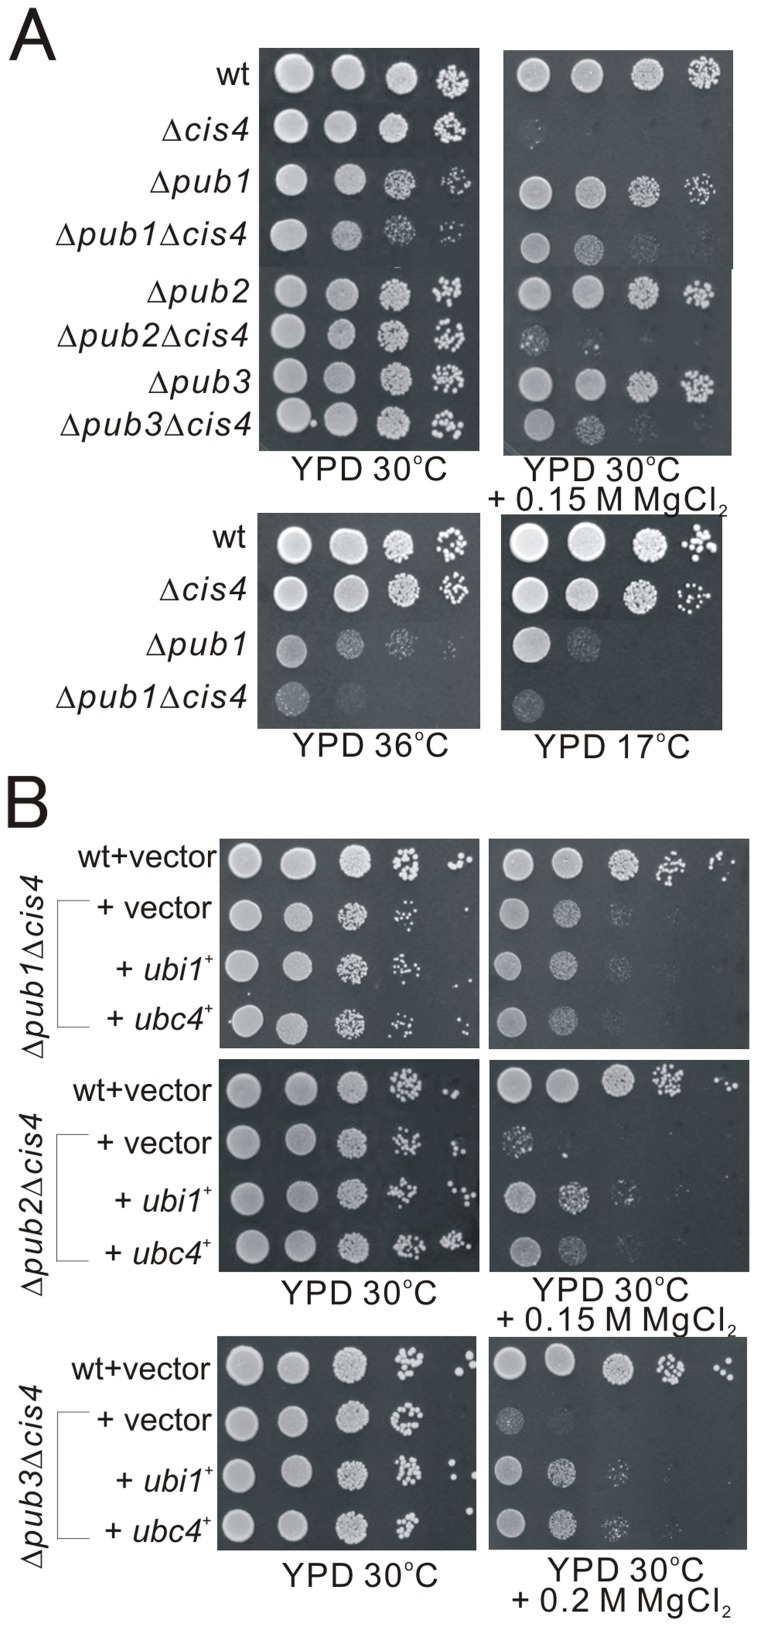
Genetic interaction between cis4
+ and pub1
+ genes.(A) The Δcis4Δpub1 mutants were more markedly sensitive to high and cold temperature than that of the Δpub1 mutants, but less sensitive to MgCl2 than that of the Δcis4 mutants. Wild-type cells, Δcis4, Δpub1, Δpub1Δcis4, Δpub2, Δpub2Δcis4, Δpub3, and Δpub3Δcis4 cells were spotted onto each plate as indicated, and then incubated at 30°C for 4 days, at 36°C for 3 days or at 17°C for 13 days. (B) Overexpression of Ubc4 or Ubi1 failed to suppress the MgCl2-sensitive phenotype of the Δcis4Δpub1 mutants, but could suppress the phenotypes of the Δcis4Δpub2 and Δcis4Δpub3 cells. Wild-type cells, Δpub1Δcis4, Δpub2Δcis4, or Δpub3Δcis4 cells transformed with a control vector or the vector containing ubi1
+ and ubc4
+ respectively, were spotted onto YPD, or YPD plus MgCl2 plates, and then incubated at 30°C for 4 days.